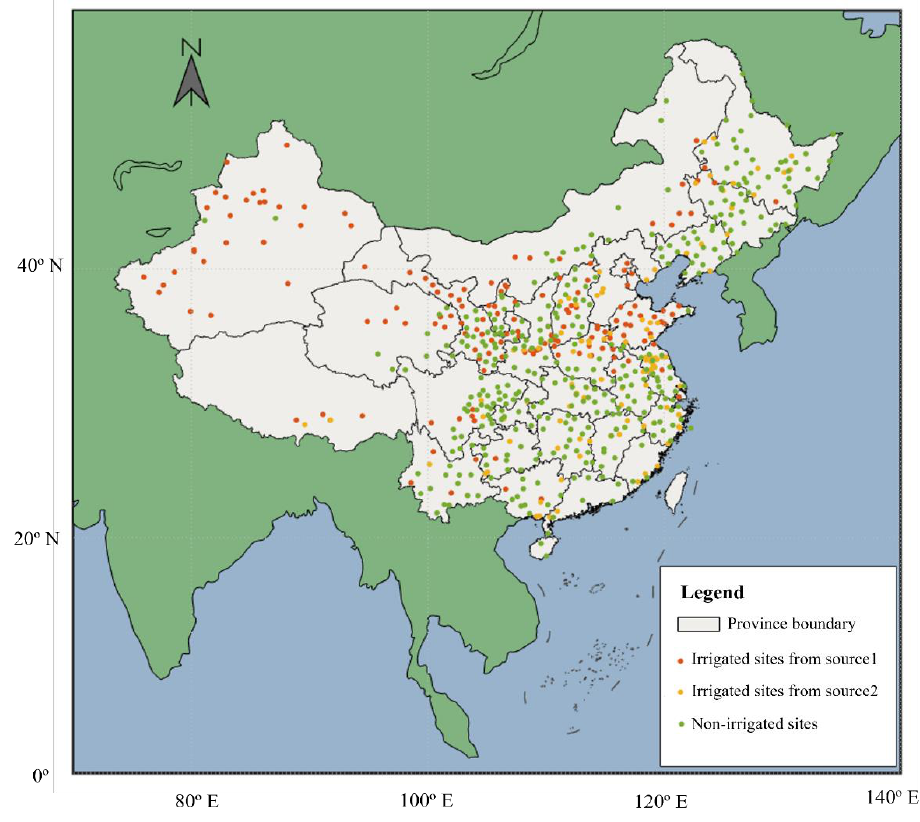
Figure 4. The distribution of validation samples in mainland